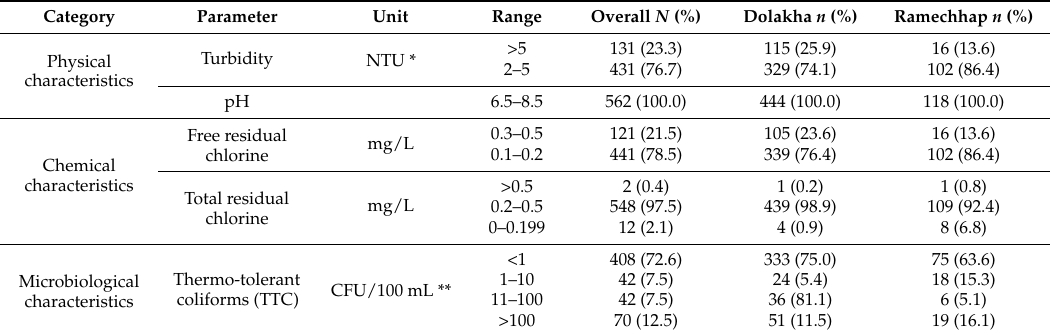
Table 5. Physicochemical and bacteriological parameters of point-of-use water samples in households in Dolakha and Ramechhap districts, Nepal (sampling period: June 2015).